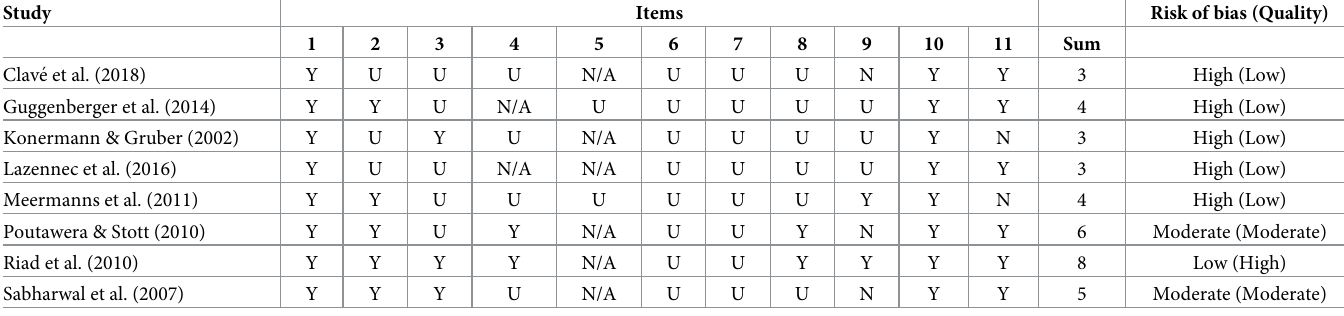
Table 4. QAREL-checklist for the evaluation of quality of the included reliability studies on imaging diagnostics for the measurement of leg length discrepancy (n =